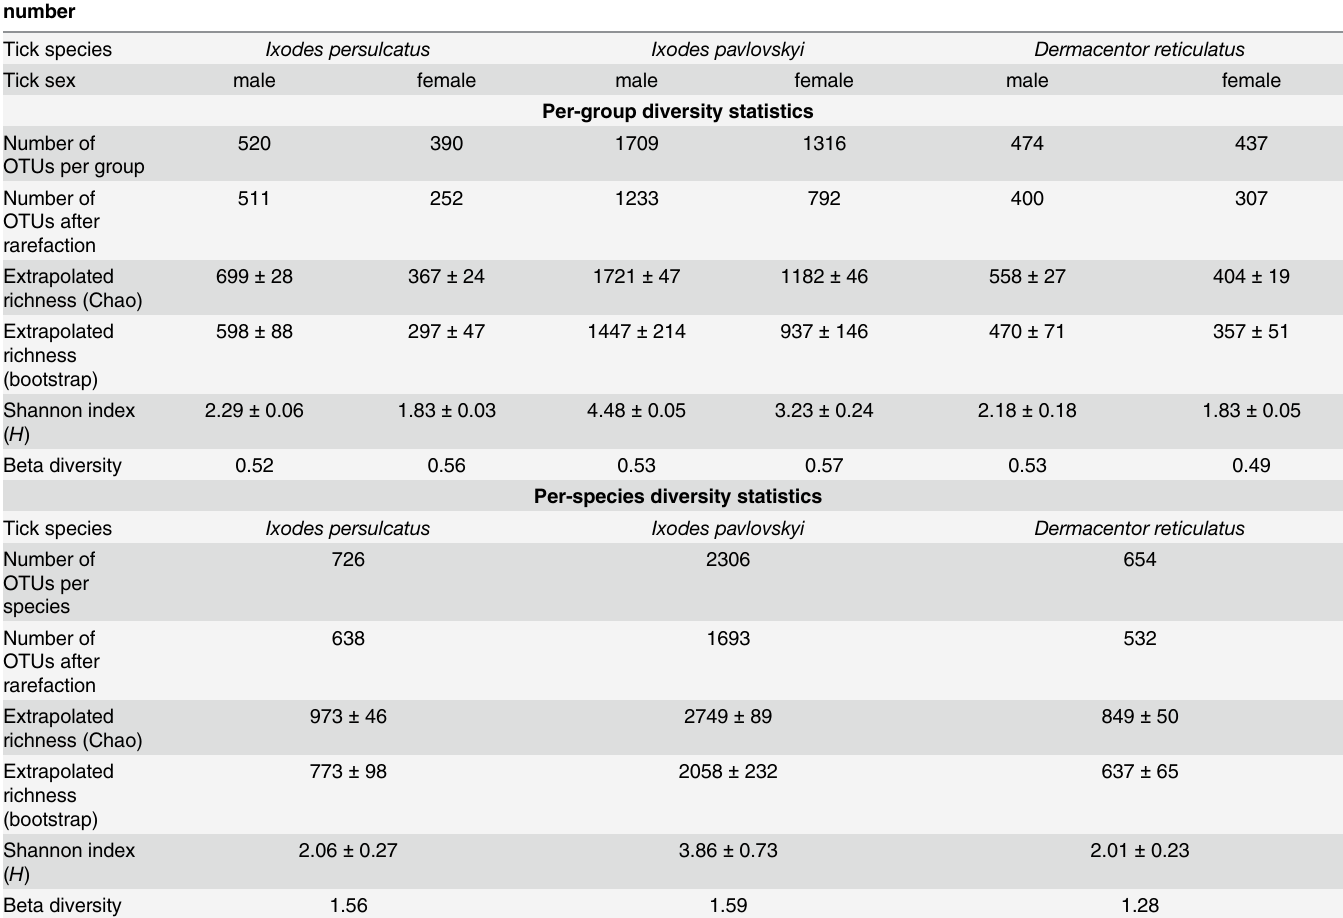
Table 2. Diversity